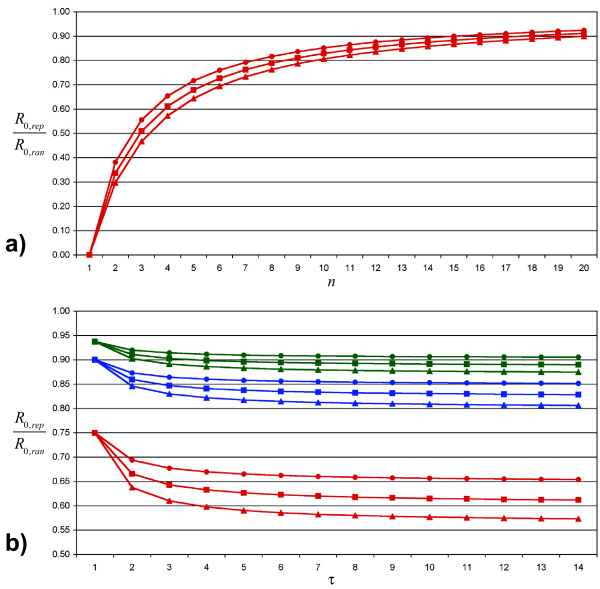
Ratio of the basic reproduction numbers. Subfigure a shows the ratio R0,rep/R0,ran (as defined in equation 1) for 1 ≤ n ≤ 20 (number of daily contacts) and τ = 14 (infectious period). Triangles stand for β·n·τ = R0,ran = 2.4, squares for R0,ran = 1.8 and circles for R0,ran = 1.2. Subfigure b gives R0,rep/R0,ran depending on the infectious period τ. Red lines and symbols are for n = 4, and blue lines stand for n = 10, whereas green lines represent n = 16. The meaning of the symbols is identical as in subfigure a.